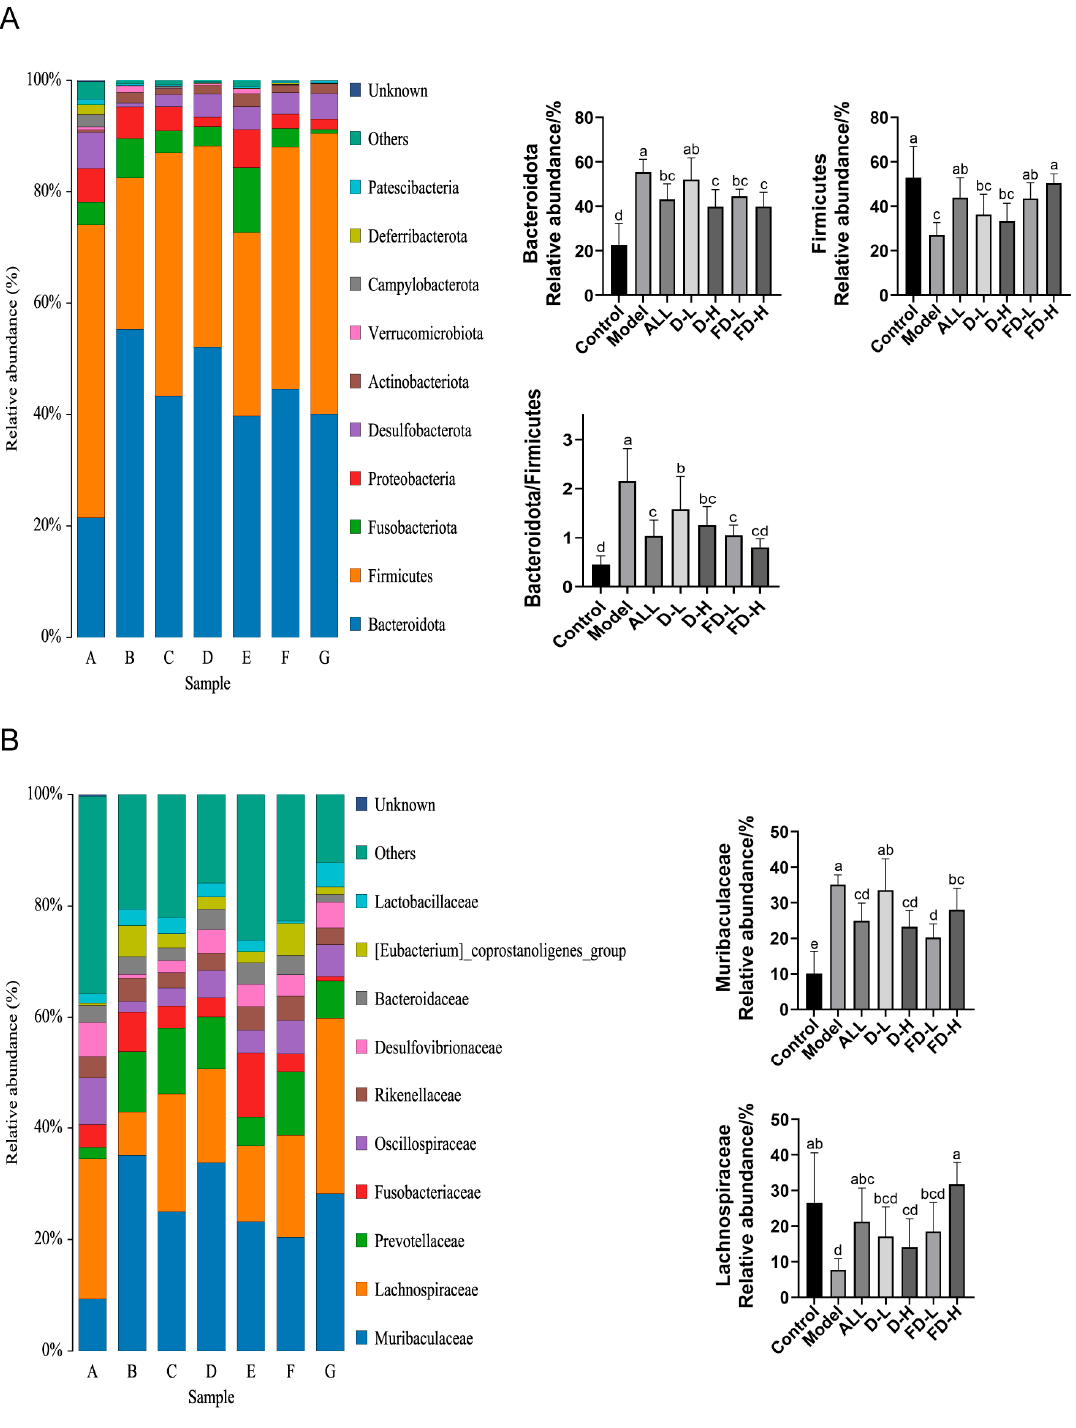
Figure 8. Effects of fermented dandelion on intestinal microbiota of mice with HUA. ( A ) Phylum level; ( B )Family level. The data are expressed as mean ± SD (n = 6). Di ff erent lowercase le tt ers indi- cate statistically signi fi cant di ff erences ( p < 0.05) between the groups. A: Control; B: Model; C: ALL, allopurinol; D: D-L, dandelion low dose group; E: D-H, dandelion high dose group; F: FD-L, low dose group of LAFD; G: FD-H, high dose group of LAFD.